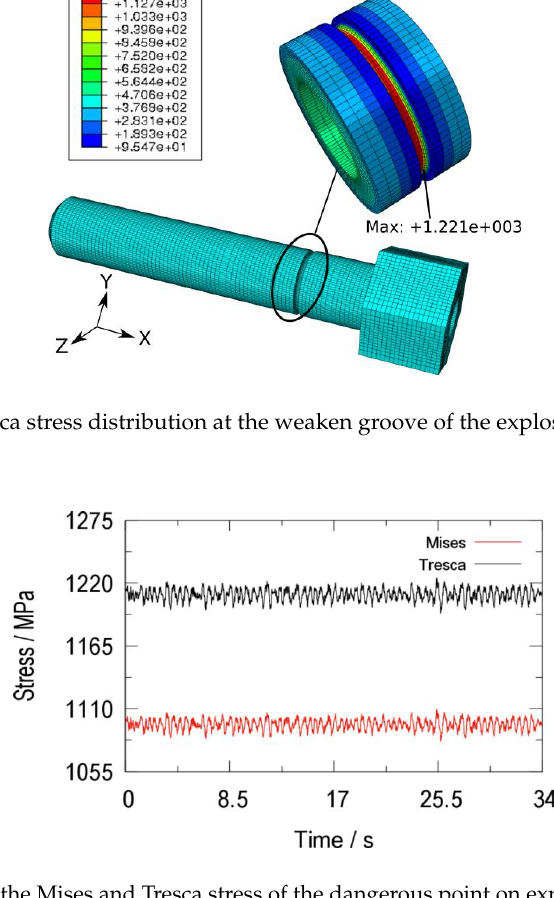
Figure 8. Variation of the Mises and Tresca stress of the dangerous point on explosive bolt C with time under Class E road.